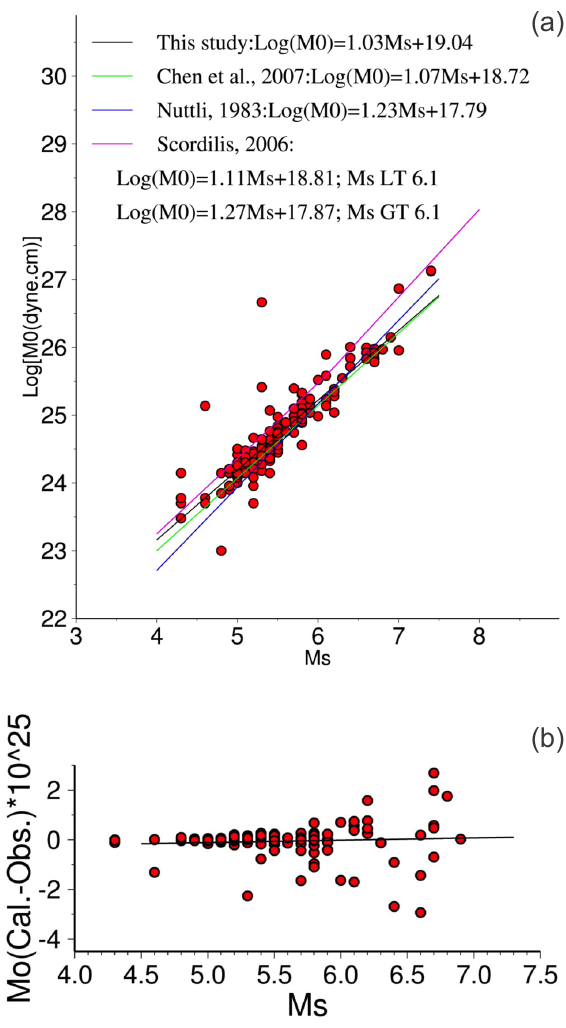
( M ) versus M for the mid-plate Iranian earth- Figure 3. (a) Log S 10 0 less than quakes. Equations for Scordilis [2006] were drawn for M S (LT) and greater than (GT) 6.1. The straight black line is for this study. (b) Residuals for scalar moment versus surface magnitude com- puted using ordinary linear